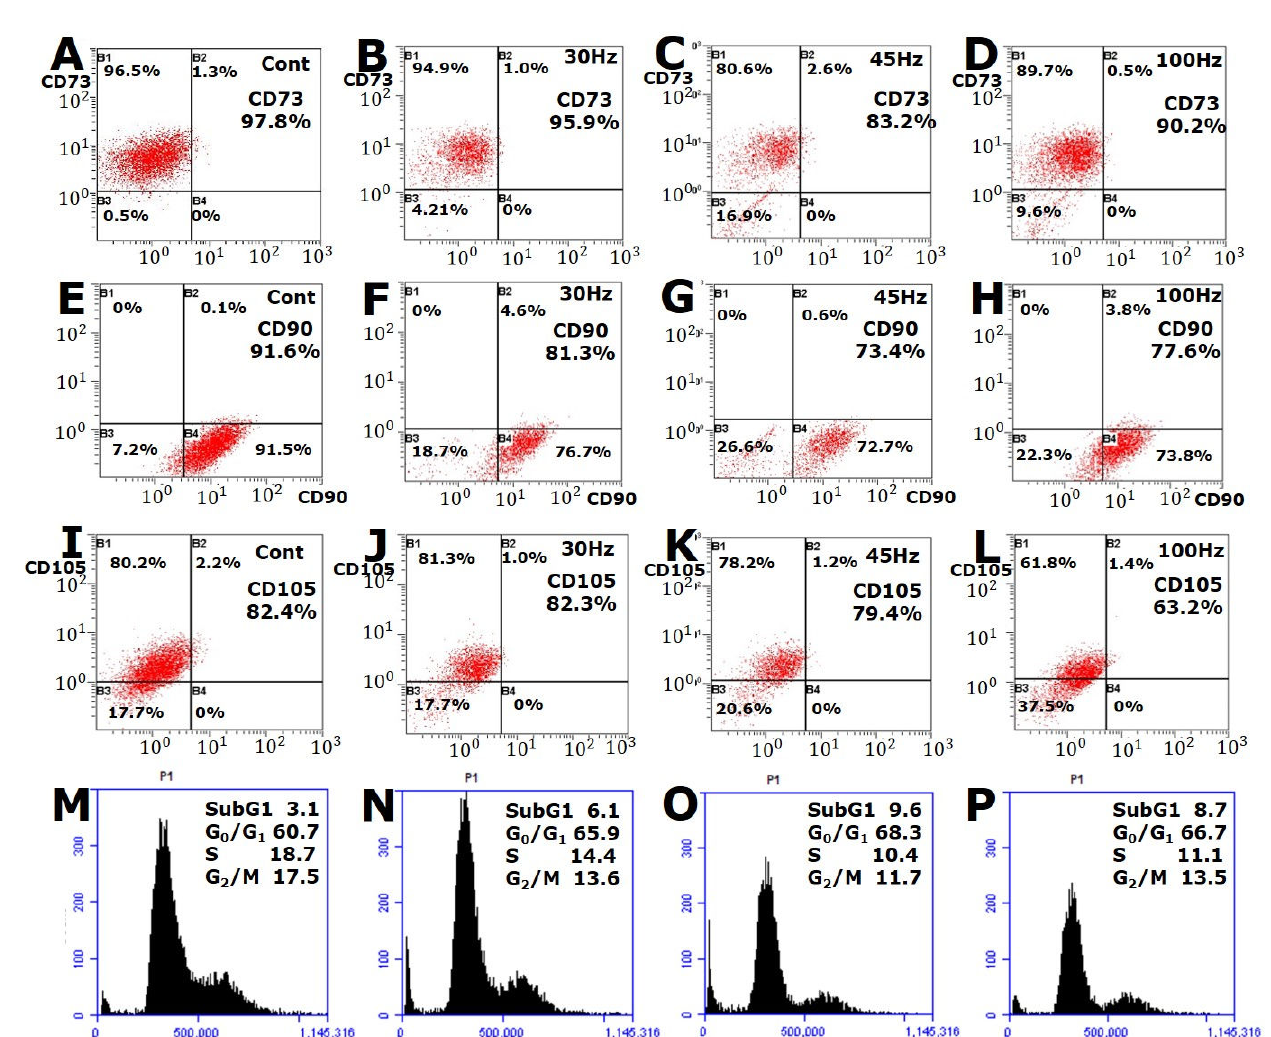
Figure 3. FACS analysis of the surface markers CD 73, CD90, and CD105 after mechanical vibration treatment for 14 d. Human dental pulp stem cells (HDPSCs) were labeled with a FITC- or PE-conjugated antibody and then analyzed in a flow cytometer. CD 73, CD 90, and CD105 expression decreased in the 45- and 100-Hz groups. HDPSCs were subjected to vibration for 7 d, and the cell cycle was assessed using propidium iodide. The percentages of the cells in the G0/G1 phase are